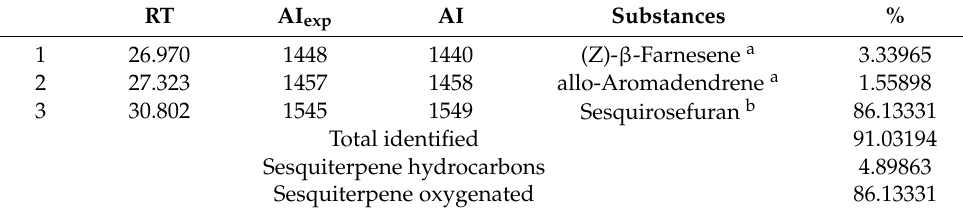
Table 1. Chemical characterization of the EO by GC-MS and